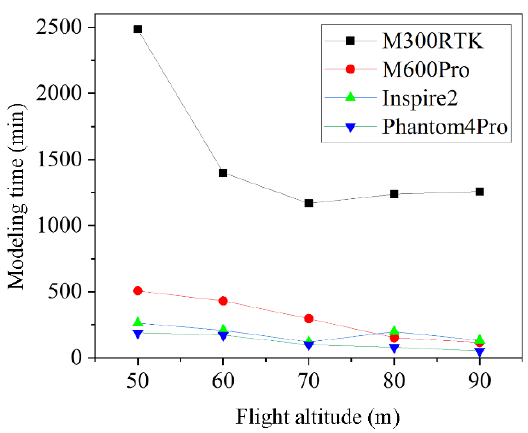
Figure 11. Flight duration of UAV at different altitudes.